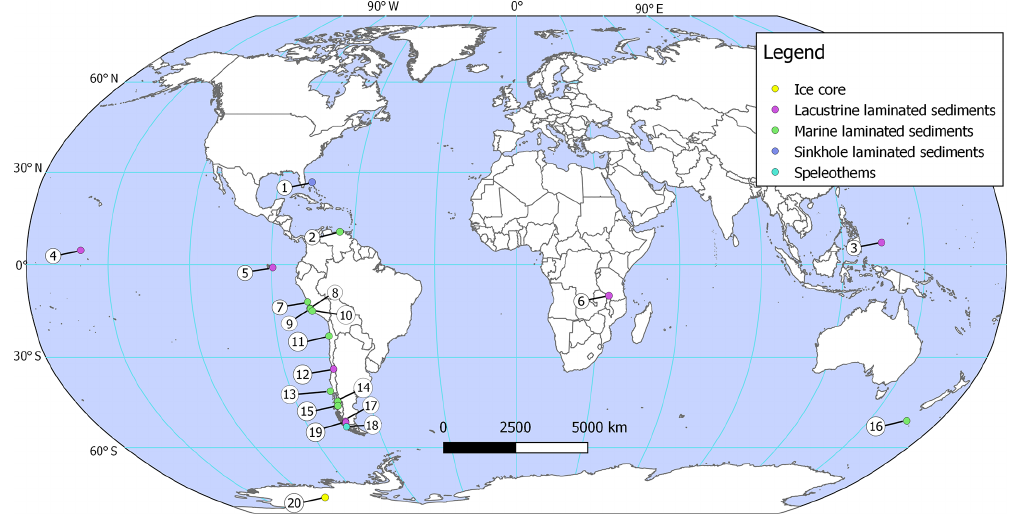
Figure 2. Global distribution of the paleoclimate and paleoenvironmental records used in this work. See Table 1 for number